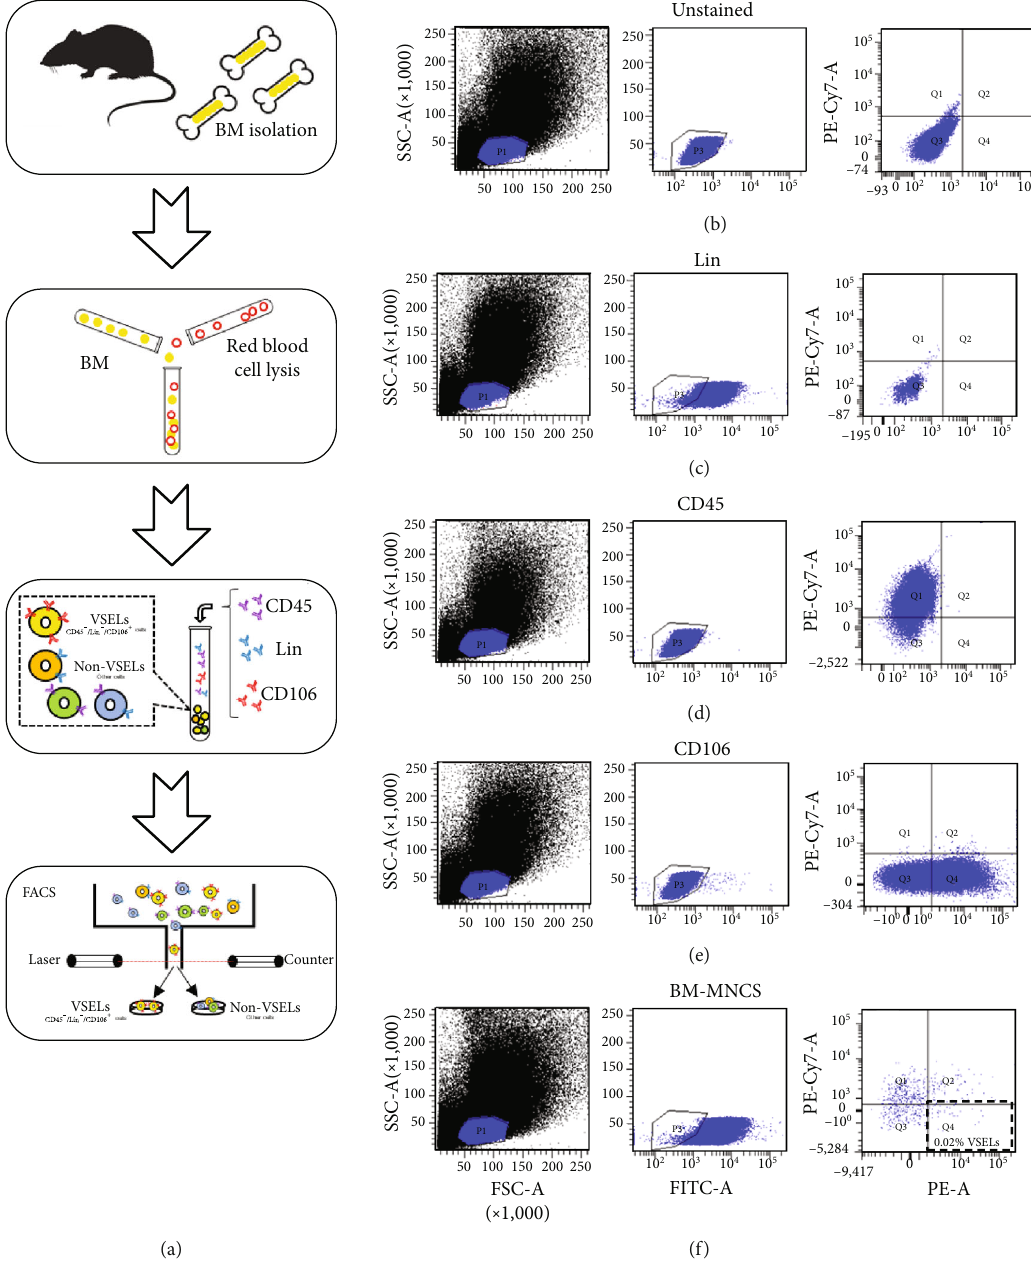
Figure 1: Rat bone marrow- (BM-) derived very small stem cells (VSELs) were successfully isolated by fl ow cytometry. (a) The tibia and femur of rats were separated, erythrocytes were lysed, and total BM mononuclear cells were extracted. Fluorophore-conjugated antibodies speci fi c to CD45, CD106, and hematopoietic markers (Lin: TCR αβ , CD3, CD11b, and CD45RA) were used. Flow cytometric sorting was carried out after incubation. (b) Blank control; (c) Lin control; (d) CD45 control; (e) CD106 control; (f) VSEL